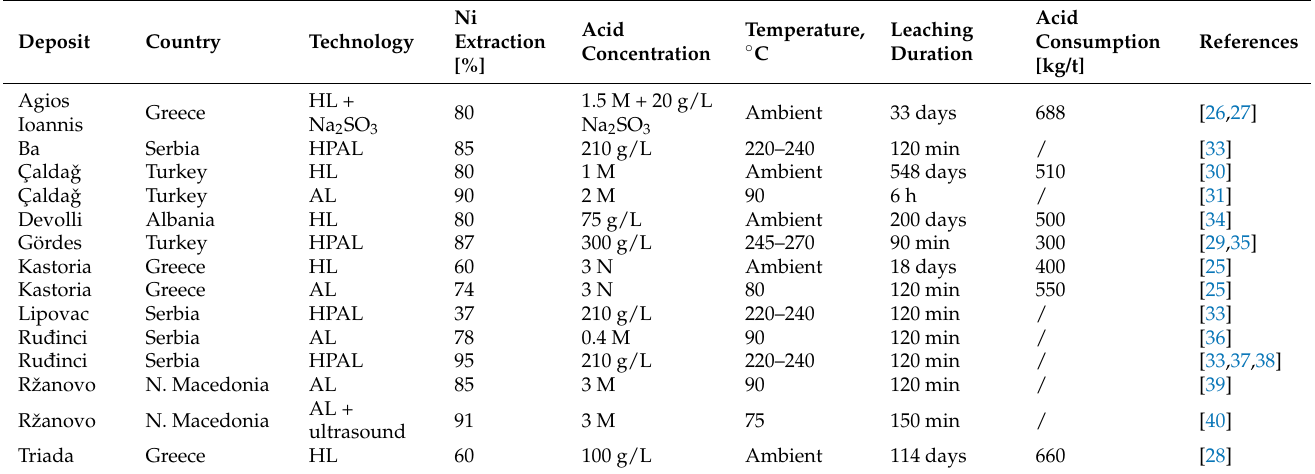
Table 5. Overview of the selected literature data on laboratory-scale experiments for leaching of lateritic ores from SEE and